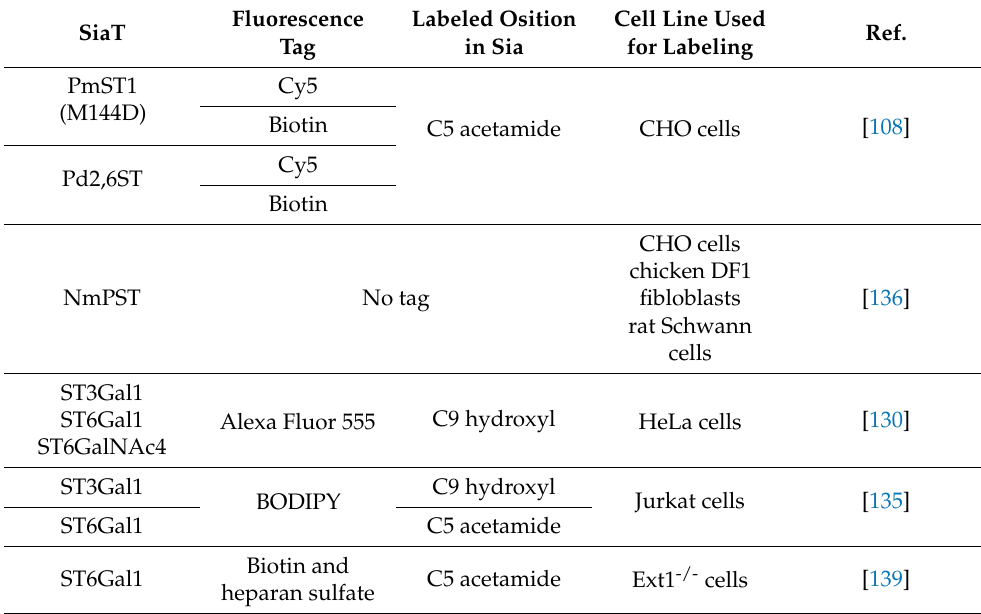
Table 4. Examples of fluorescent labeling of cell-surface sialoglycans using recombinant SiaT. Fluorescence SiaT